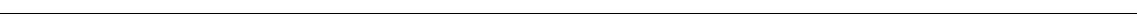
Fig. 1 Mural Pparg overexpression drives healthy visceral WAT expansion in obesity. a Pdgfrb rtTA ; TRE - Pparg2 (Mural- Pparg TG ) mice are generated by breeding the Pdgfrb rtTA transgenic mice to animals expressing Pparg2 under the control of the tet-response element ( TRE - Pparg2 ). Littermates carrying only Pdgfrb rtTA or TRE - Pparg2 alleles were used as the control animals for Mural- Pparg TG . Pdgfrb rtTA ; TRE - Cre ; Rosa26R mT/mG ; TRE - Pparg2 (MuralChaser- Pparg TG ) mice are generated by breeding the “ MuralChaser ” ( Pdgfrb rtTA ; TRE - Cre ; Rosa26R mT/mG ) mice to animals carrying TRE - Pparg2 transgene. MuralChaser mice were used as control animals for MuralChaser- Pparg TG . b Control and Mural- Pparg TG mice were fed a standard chow diet until 6 weeks of age before being switched to dox-containing high-fat diet (HFD). Body weights were measured weekly following the onset of HFD feeding. Control-HFD, n = 8; Mural- Pparg TG -HFD, n = 9. Data points represent mean + s.e.m. c Fat mass and lean mass (normalized to body weight) of control and Mural- Pparg TG mice after 16 weeks of dox-HFD feeding. Control-HFD, n = 8; Mural- Pparg TG -HFD, n = 9. Bars represent mean + s.e.m. d Fat pad weight (normalized to body weight) of control and Mural- Pparg TG mice after 16 weeks of dox-HFD feeding. * denotes p < 0.05 from Student ’ s t -test. Control-HFD, n = 8; Mural- Pparg TG -HFD, n = 9. Bars represent mean + s.e.m. e – h Representative immuno fl uorescence staining of Perilipin (green) and Mac-2 (red) in e , f gonadal and g , h perirenal WAT paraf fi n sections obtained from control and Mural- Pparg TG mice after 16 weeks of dox-HFD feeding. Scale bar, 200 μ m. i Number of crown-like structures (Mac-2 positive) in the indicated depots from control and Mural- Pparg TG mice after 16 weeks of dox-HFD feeding. * denotes p < 0.05 from Welch ’ s t -test. n = 24 randomly chosen ×10 magni fi cation fi elds from six individual animals. Bars represent mean + s.e.m. j Average adipocyte size in indicated fat depots from control and Mural- Pparg TG mice after 16 weeks of dox-HFD feeding. * denotes p <0.05 from Student ’ s t -test. n = 6 per genotype. Bars represent mean + s.e.m. k – r Representative ×63 magni fi cation confocal immuno fl uorescence images of k – n gonadal and o – r perirenal WAT sections from MuralChaser and MuralChaser- Pparg TG mice after 16 weeks dox-diet feeding. Sections were stained with anti-GFP (green) and anti-Perilipin (red) antibodies and counterstained with DAPI (blue; nuclei). * indicates GFP-labeled perilipin-positive cells. Scale bar, 50 μ m. s – t Percentage of perilipin-positive adipocytes expressing GFP in s gonadal and t perirenal WAT from MuralChaser and MuralChaser- Pparg TG mice maintained on dox-diets for 16 weeks. Two-way ANOVA, * p <0.05; n = 6 individual depots per group. Bars represent mean + s.e.m. u , v Relative mRNA levels of indicated genes in u gonadal and v perirenal WAT obtained from control and Mural- Pparg TG mice after 16 weeks of dox-HFD feeding. * denotes p <0.05 from Welch ’ s t -test. n = 6 per genotype. Bars represent mean +